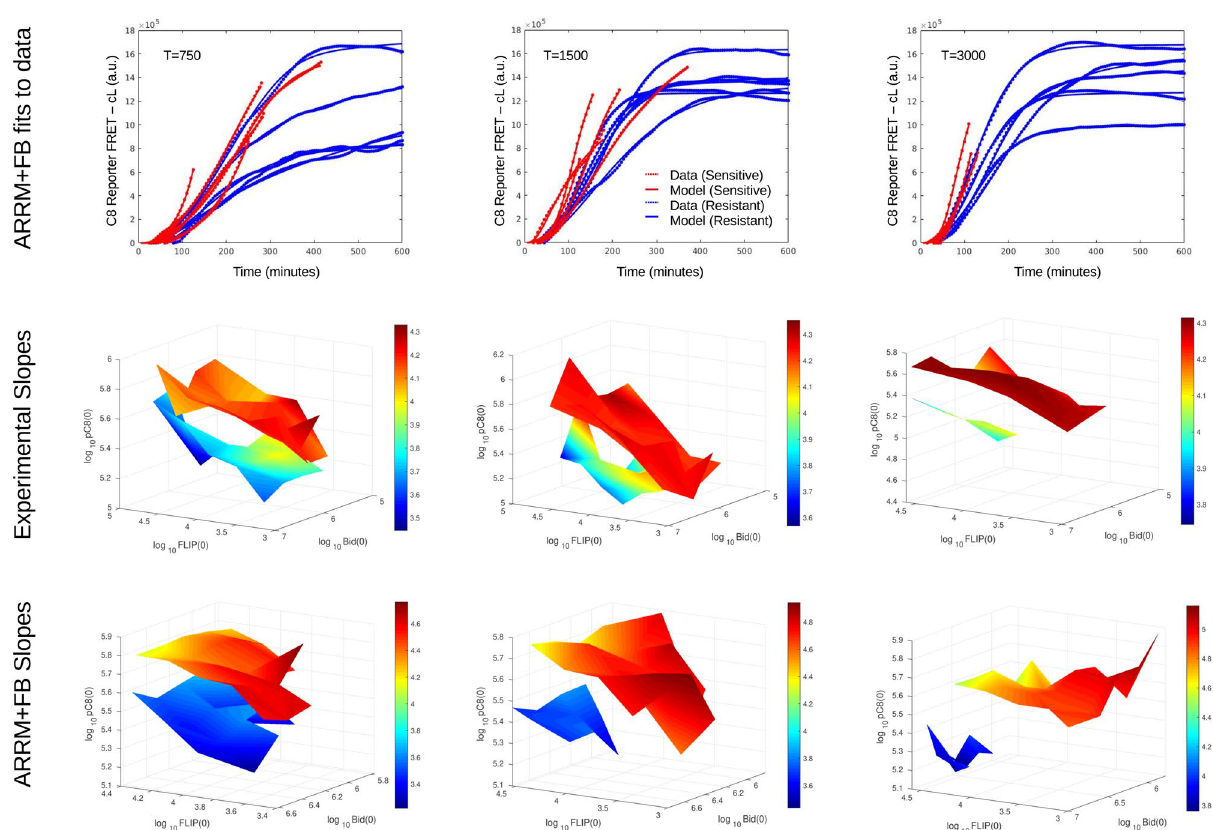
Figure 6. Estimating initial conditions for all cells with ARRM+Feedback k 23 ( C 8 ) for the three TRAIL dose groups, T = 25 ng / ml ≈ 750 molecules, T = 50 ng / ml ≈ 1500 , and T = 100 ng / ml ≈ 3000 molecules. In the middle and bottom rows, base 10 logarithms of all quantities are used. Top row: Examples of fits for resistant (blue) and sensitive (red) cells. Middle row: Projection of the estimated experimental conditions into the (FLIP,Bid,pC8) space. Each surface corresponds to one phenotype (blue tones: resistant; red tones: sensitive). To obtain each surface, we averaged the values of pC8(0) over intervals of (FLIP,Bid). The surfaces are colored according to maximal slope values, also averaged over intervals of (FLIP,Bid). Bottom row: Comparison to model results. Random initial conditions (about 400) were generated for each TRAIL concentration and the maximal slopes were measured. The experimental maximal slope-thresholds separating resistant and sensitive cells were used to obtain two phenotypes. The model results are analyzed in the same way as the experimental results in the middle